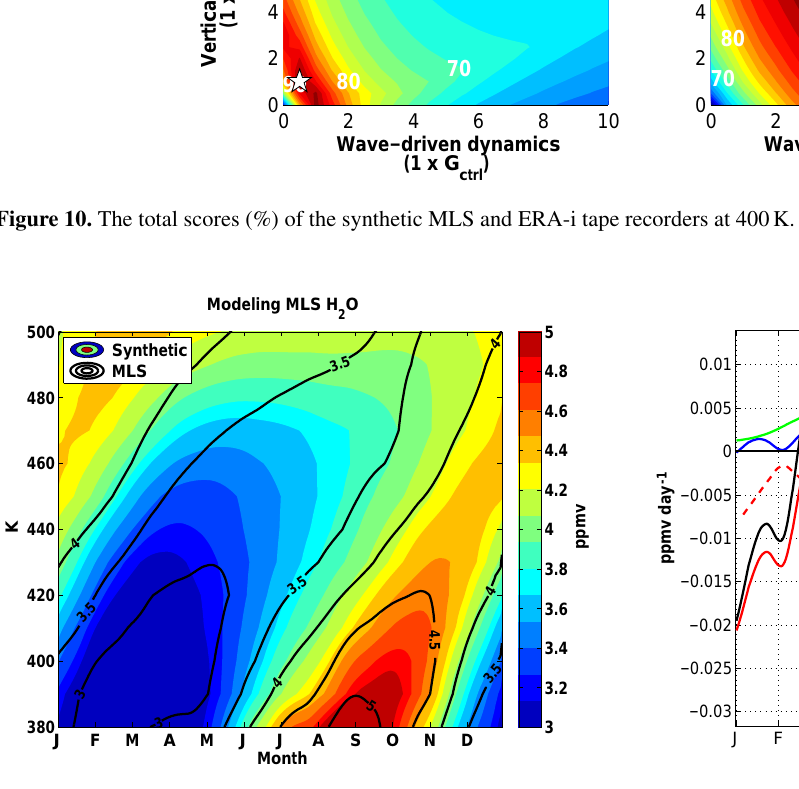
Figure 12. The contributions to the water vapor tendency (ppmvday − 1 ) at 400K from the best synthetic 1-D transport model solution for MLS ( a = b = c = 1; corresponding to the white star in the left panel of Fig. 10). The red dashed line shows the tendency due to vertical advection (diabatic heating) from